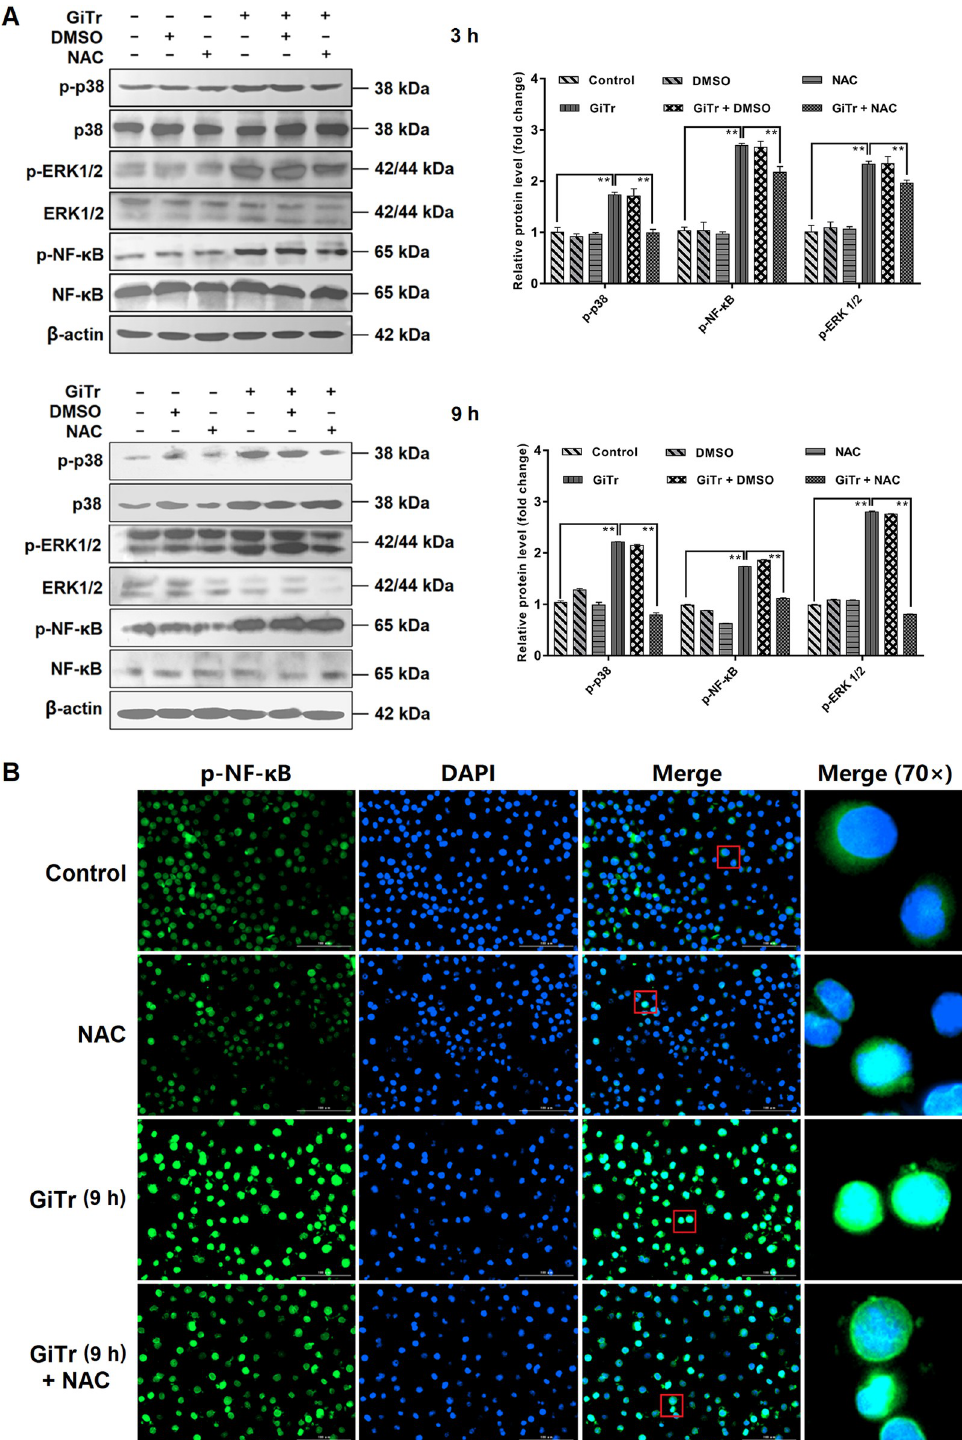
Fig 6. ROS influenced the activation of MAPK/NF- κ B signaling. Prior to exposure to Giardia for the indicated time periods, J774A.1 cells were incubated with or without ROS inhibitor NAC for 1 h. Mock groups were included. (A) ROS inhibition affected Giardia -induced p38, ERK, or NF- κ B activation as assessed by western blot and gray value analyses. (B) ROS inhibition affected Giardia -induced NF- κ B nuclear translocation as examined by indirect immunofluorescence staining (scale bar = 100 μ m). The results of western blot analysis were normalized against the level of β -actin. Data